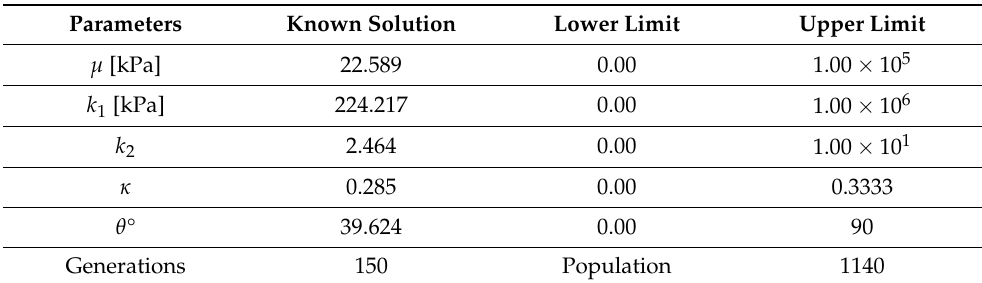
Table 1. Search parameters of ES and known solution. Parameters